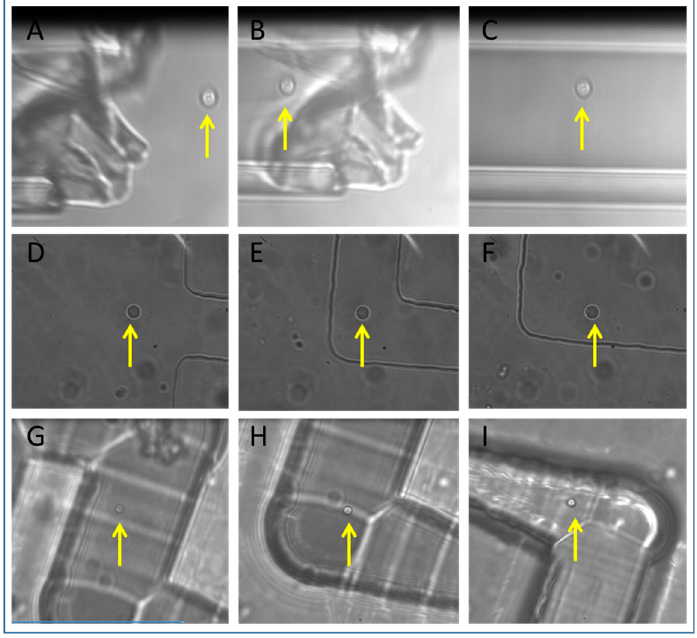
Figure 7. Tweezing and isolation of S. cerevisiae in 3 devices. ( A ) Micropipette, ( B ) PDMS chip, ( C ) ULI chip. The diameter of yeast cells (highlighted by yellow arrow) is approximately 5 µm.